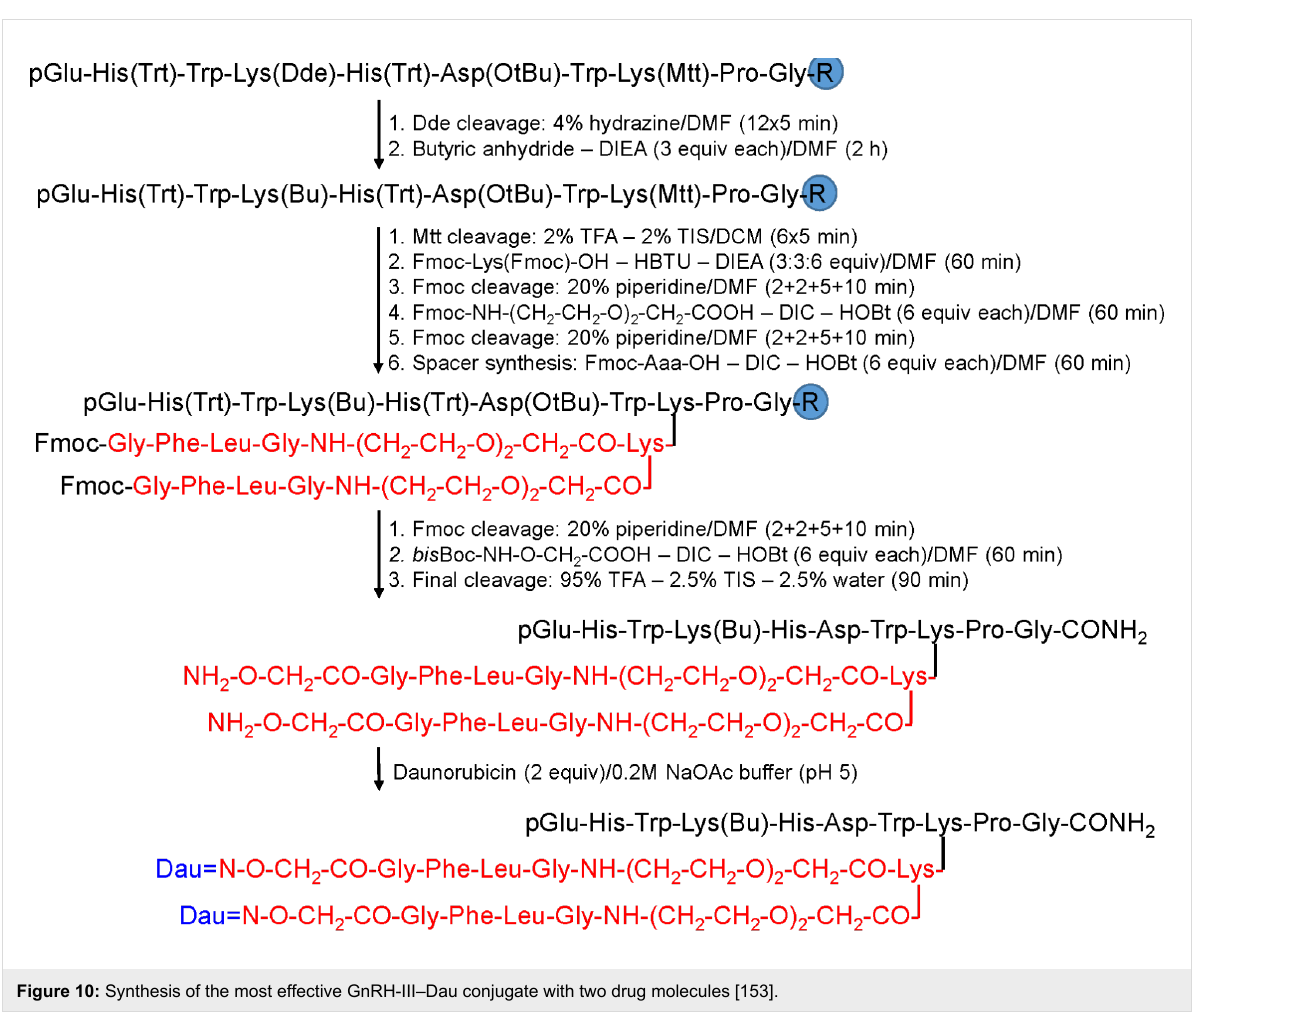
Figure 10: Synthesis of the most effective GnRH-III–Dau conjugate with two drug molecules [153].